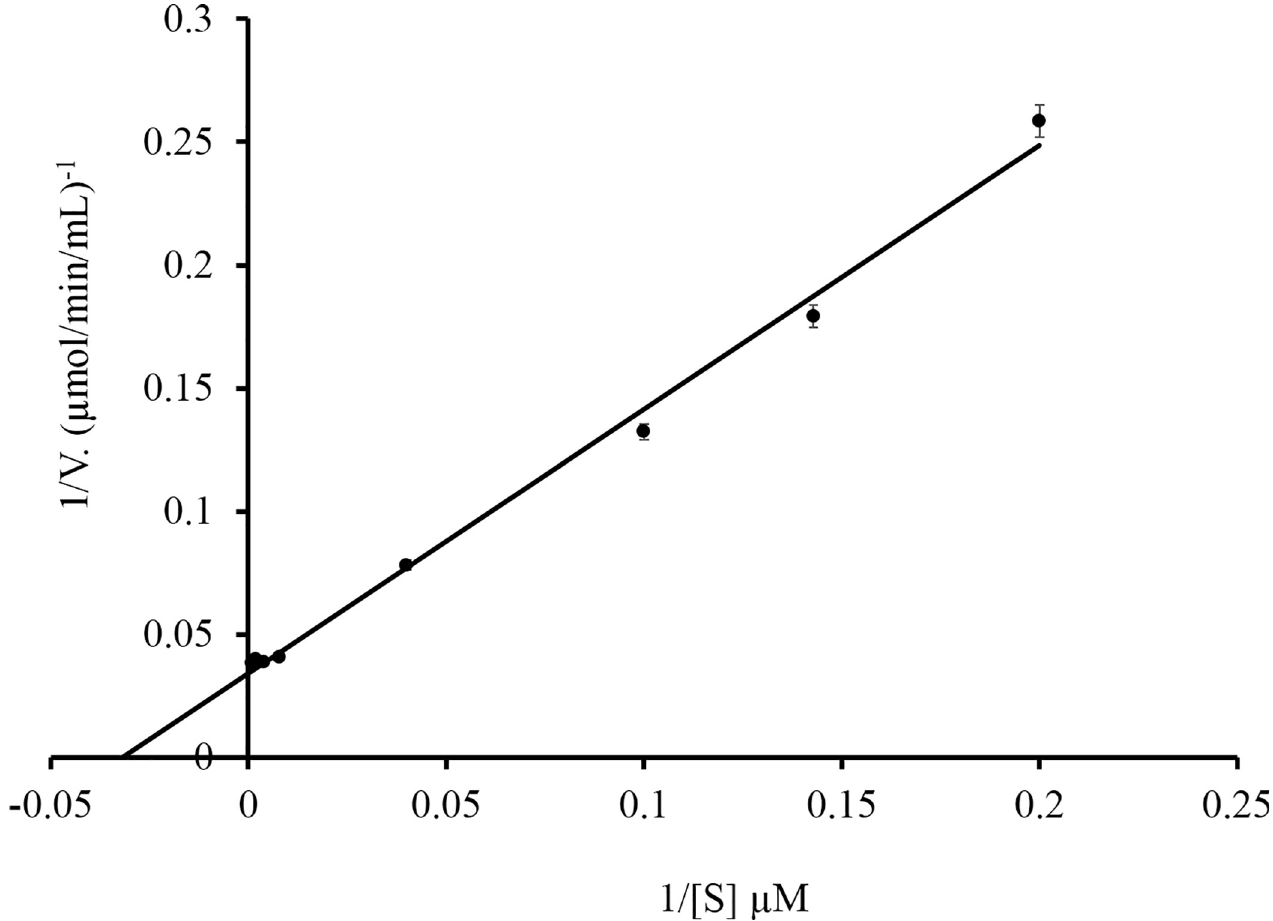
Fig 8. Lineweaver-Burk plot for recombinant cholesterol oxidase in the presence of various concentrations of cholesterol (0–1 mM).